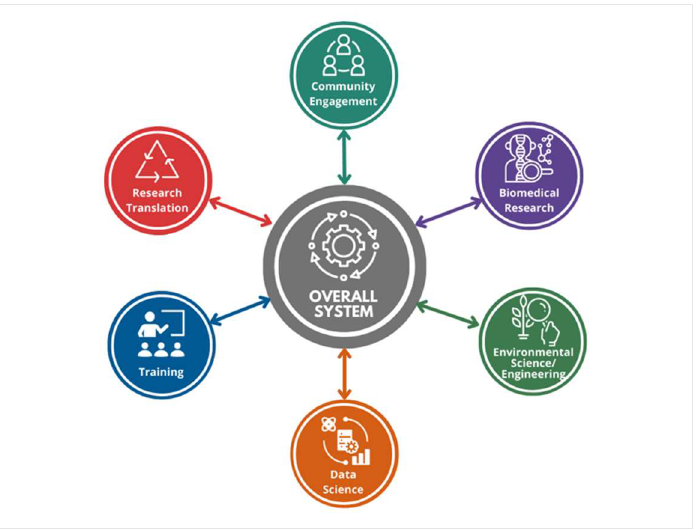
Figure 1. SRP-funded multiproject centers combine biomedical research, environmental science and engineering, research translation, community engagement, training, and data science to understand and address a specific problem. Leveraging a systems approach can advance SRP science that converges across disciplines, while building the foundation for researchers to address difficult emerging environmental health problems, such as climate change.